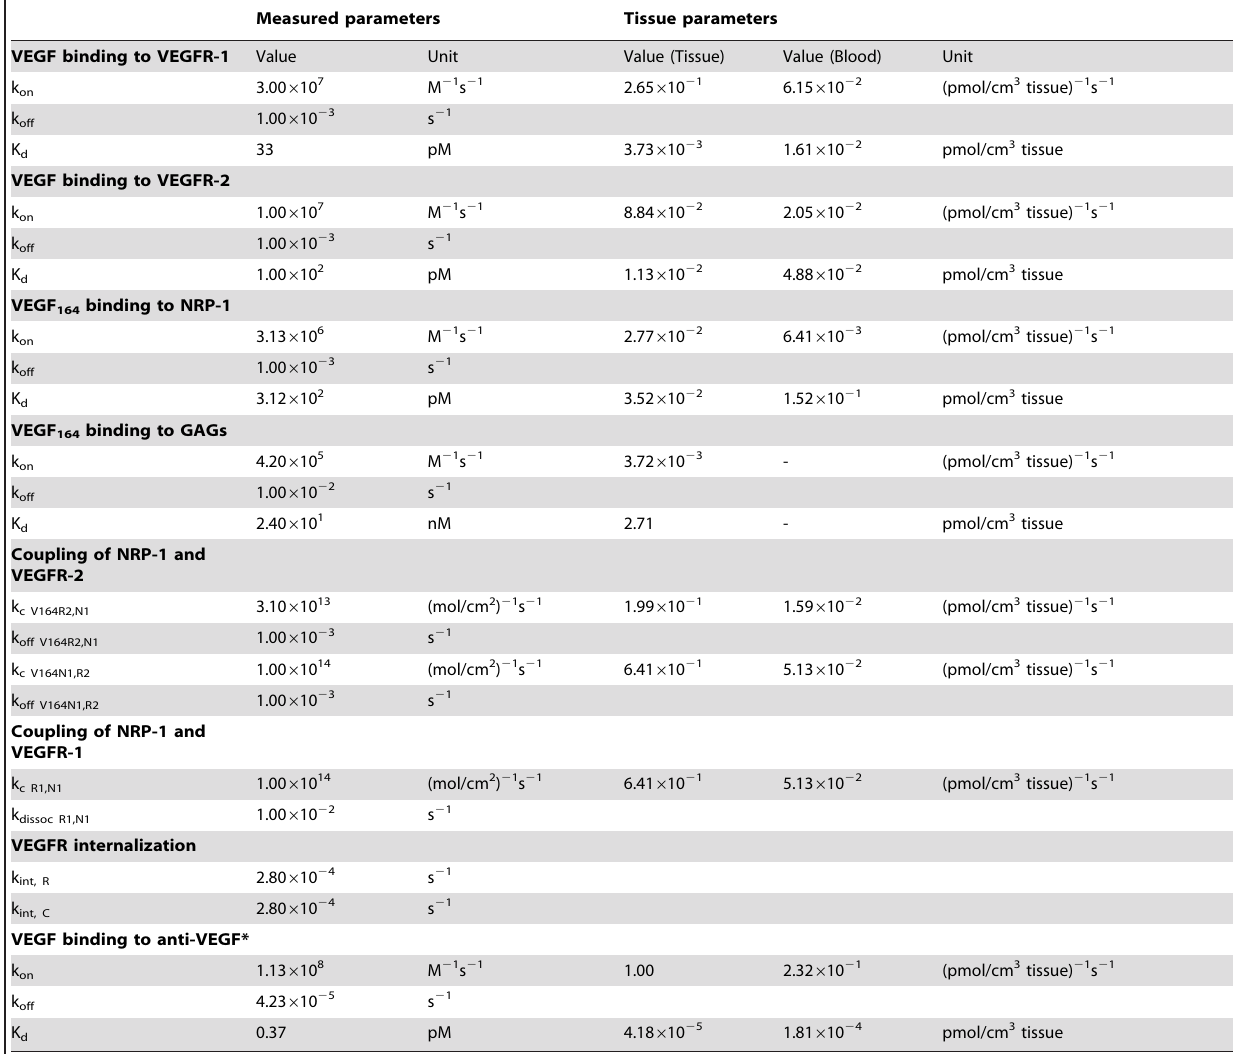
Measured parameters Tissue